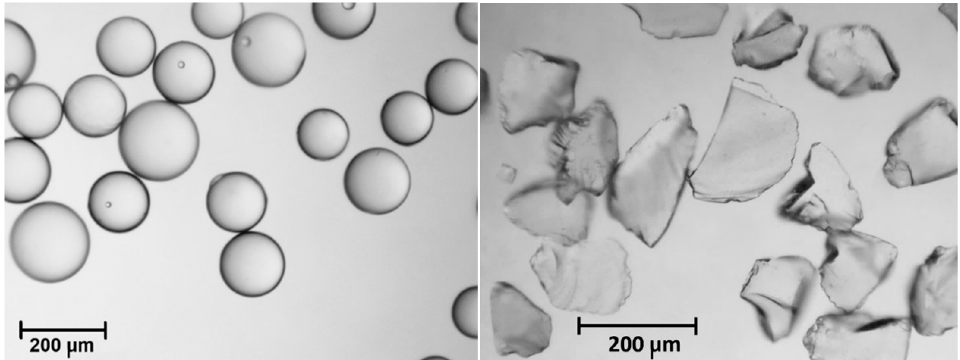
Figure 5. Microscopic view of the silica gels: on the left side—SG from Fuji Silysia Chemical Ltd.; on the right side—SG from Sigma Aldrich. the right side—SG from Sigma